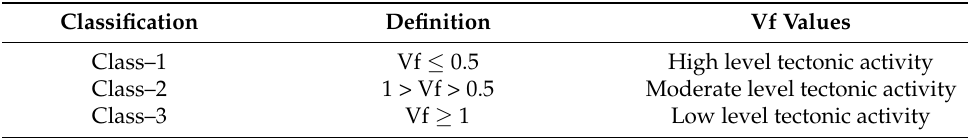
Figure 8. Measurement of valley floor width to height ratio. Table 2. Classification of Vf index. High Vf values (greater than 1), depicted by a broad U-shaped valley, indicate lateral erosion because of the stability of the base level or tectonic quiescence. In contrast, low Vf values (less than 0.5), depicted by a V-shaped valley, indicate tectonic uplift. Vf values in between 0.5 and 1 are considered moderate level tectonic activity